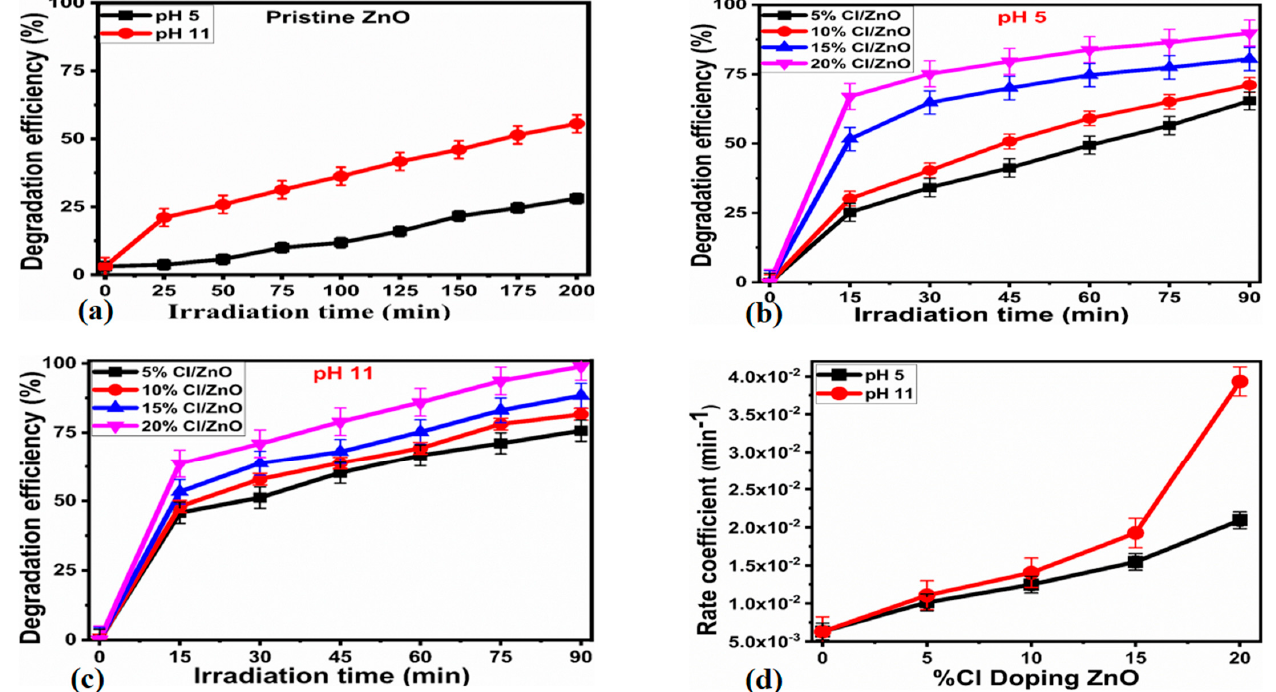
Figure 8. ( a ) Degradation efficiency of pristine ZnO at pH 5 and 11. ( b ) Degradation efficiency of Cl − -doped ZnO nanostructures at pH 5. ( c ) Photodegradation efficiency of Cl − -doped ZnO nanostructures at pH 11. ( d ) Degradation rate with increasing Cl − concentration with ZnO at pH 5 and